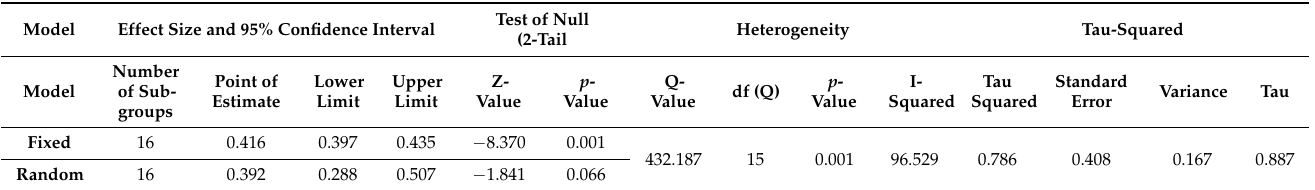
Table 2. The impact analysis values for the 16 subgroups within the 4 included studies in the meta- analysis, the homogenous distribution value, the average effect size, and the confidence intervals.